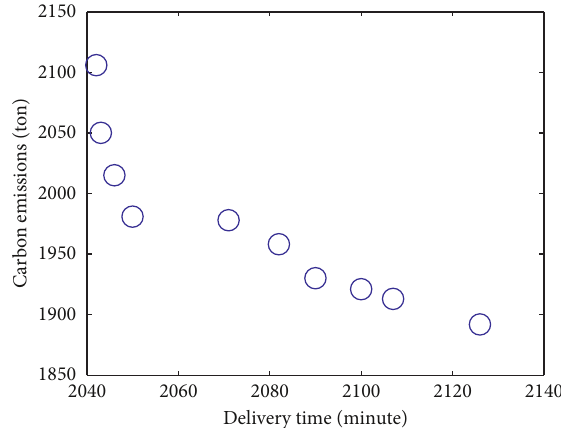
Figure 1: Pareto solution of the multiobjective remanufacturing production